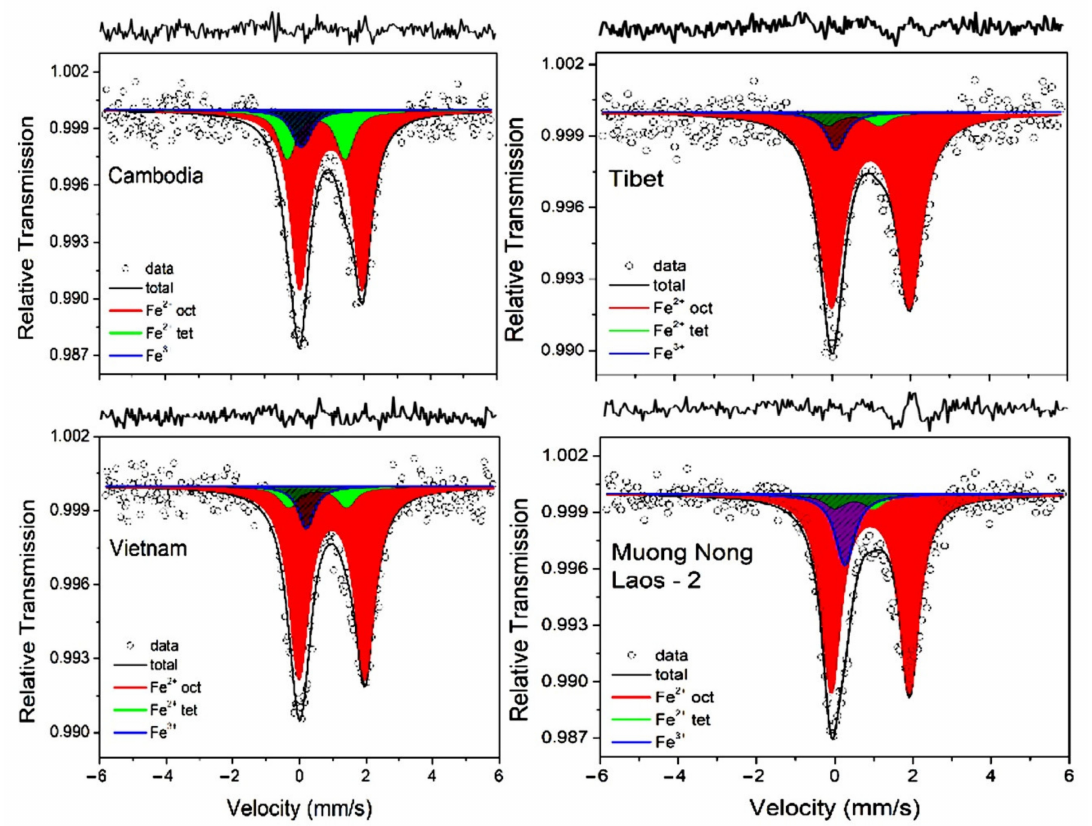
Figure 21. 57 Fe Mössbauer spectra taken at RT in transmission geometry of some groups of